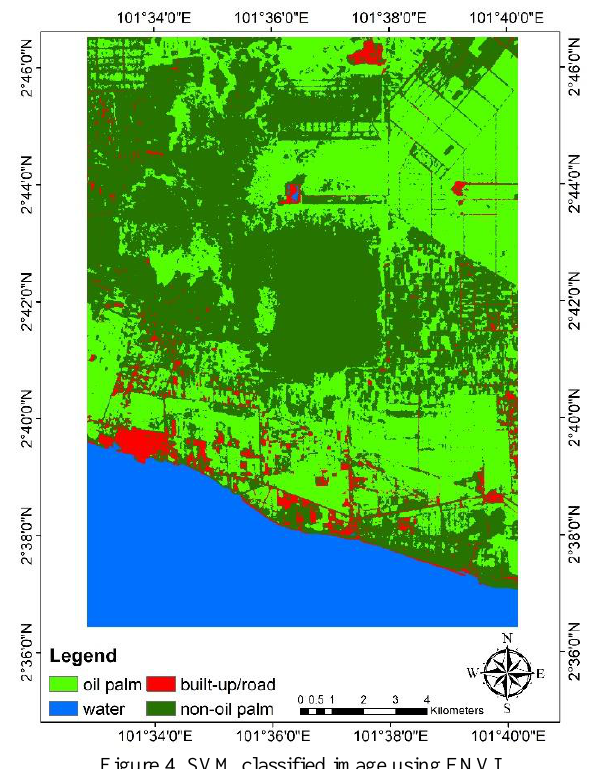
Figure 4. SVM classified image using ENVI